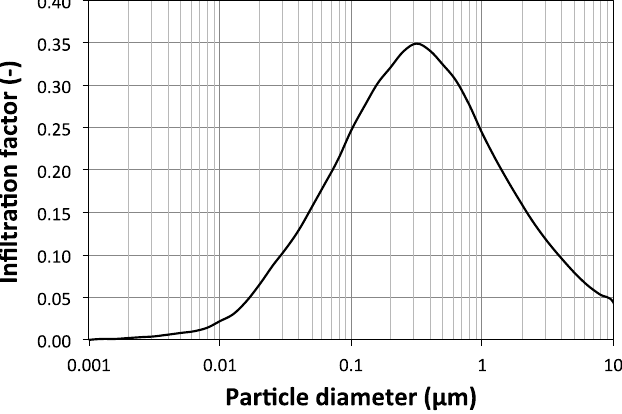
Figure 6. Size-resolved infiltration factors assumed in the analysis in Figure 5 [27,29].